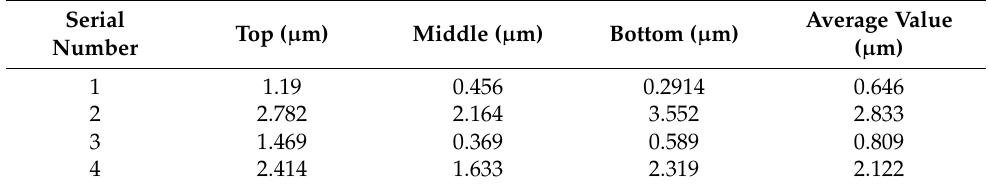
Figure 14. The stress-strain curve of the highest UTS under the parameters of HRS and ultra-HRS, respectively. Table 4. Variables corresponding to the IMC thickness of different parts of the AlFe interface, under the parameters given in Table 2.